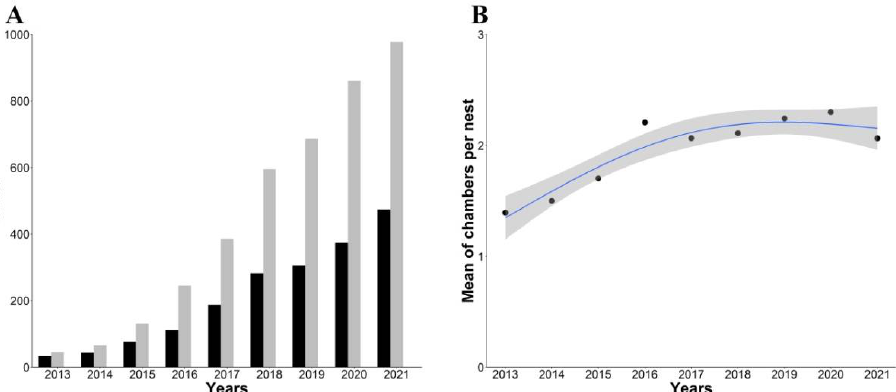
Figure 2. Population trends of ( A ) rose-ringed and ( B ) monk parakeets established in the metropol- itan area of Seville from 2013 to 2021. Blue lines show model fit estimated throughout GLM (nega- tive binomial error distribution, log link function). Grey area: 95% confidence interval. During the same period, we recorded a total of 714 different monk parakeet nests just before the breeding season (Figures 3A). The number of nests increased from 33 in 2013 to 474 in 2021 (Figure 3A). These nests were located at an average height above ground of 10.46 (SD = 3.88) m. All nesting substrates were trees of nine different species, two of which (the palms Phoenix dactylifera and P. canariensis ) accounted for 88.7% of the total (Table S3). The nests remained on the same substrate between years (mean = 3.96 years, range: 1–9 years), and although 338 nests were destroyed during the study period, 38.3% were subsequently rebuilt on the same substrates. However, 33.61% of the recorded nests were lost by 2021, mainly due to removal actions (65.83%), the death of the arboreal sub- strate by parasites (23.75% of palms were killed by the red palm weevil Rhynchophorus ferrugineus , order Coleoptera), or storm toppling (4.58%). Only 5.83% of the nests were abandoned for unknown reasons.